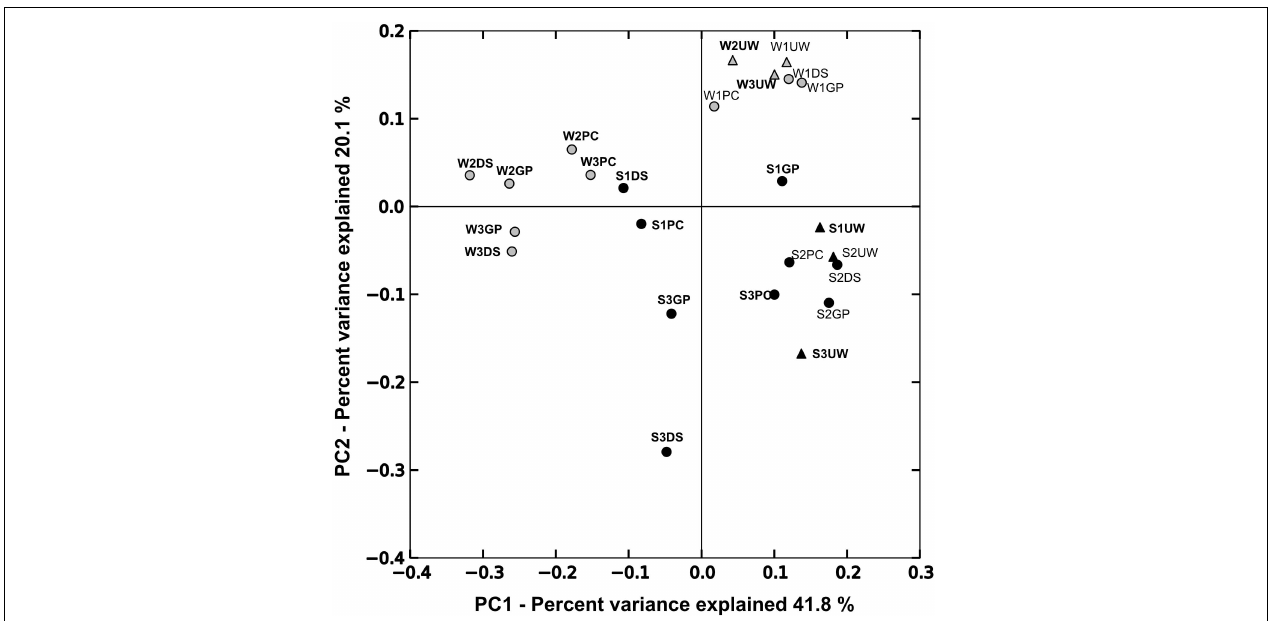
FIGURE 2 | Fast UniFrac weighted principal coordinate analysis (PCoA) plots based on the relative bacterial abundances in each sample. Circles indicate samples collected from the SML while UW samples are represented by triangles. Samples collected during summer (S) are indicated in black and winter samples (W) are indicated in gray. Sample names highlighted in bold indicate chl-a and TEP enrichment in the